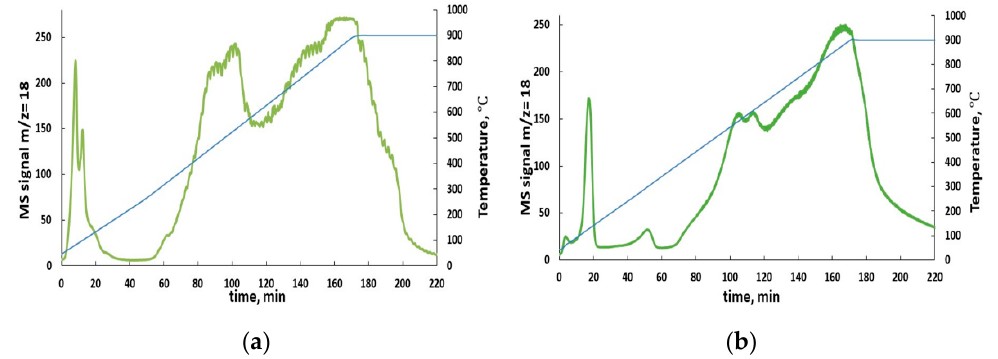
Figure 4. Temperature Programmed Reduction (TPR) water evolution spectra of as-prepared BaFeHF ( a ) and BaFeHAl ( b ). Table 2. Phase composition of 6%K/BaFeHAl-30 and 6%K/BaFeHF-18 after H 2 -reduction.